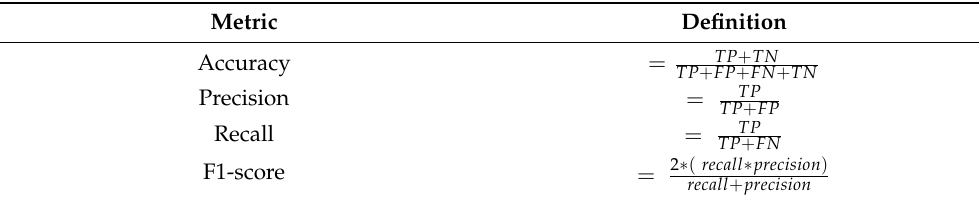
Table 1. Evaluation metrics.